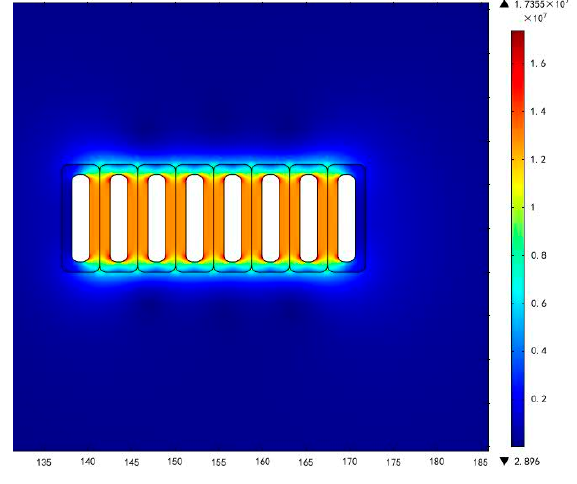
Figure 10. Electric field distribution.